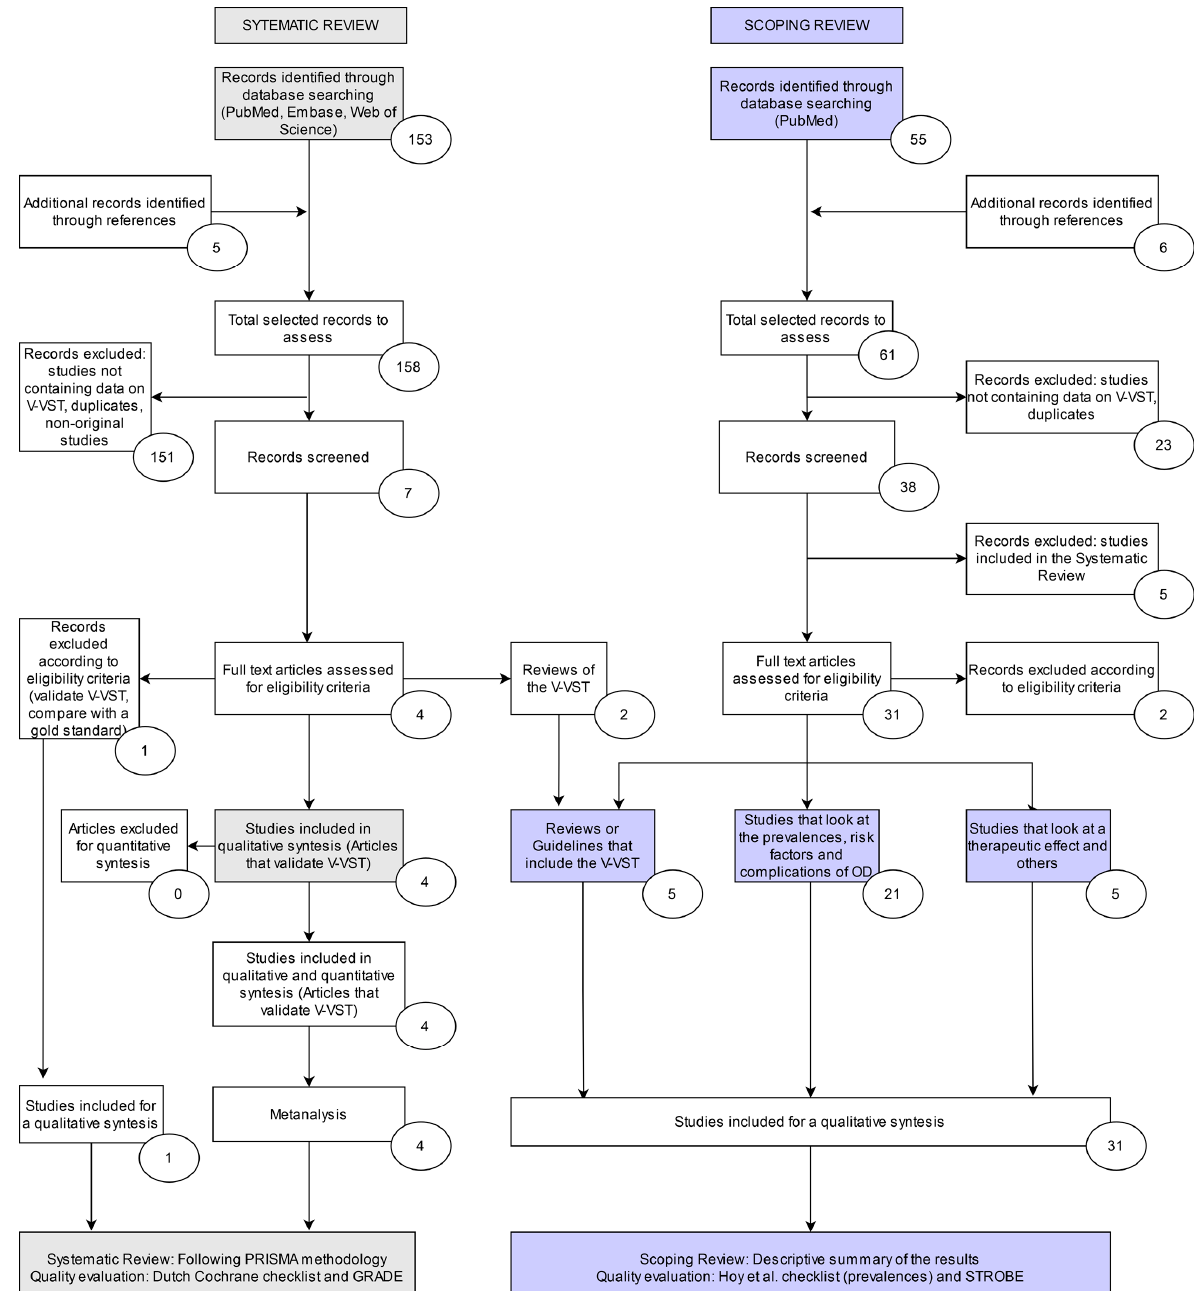
Figure 2. Systematic review (SR) and scoping review (ScR) flowcharts following the PRISMA guidelines [14,15] showing the selection process for the articles finally included in the SR ( n = 5) and the ScR ( n =